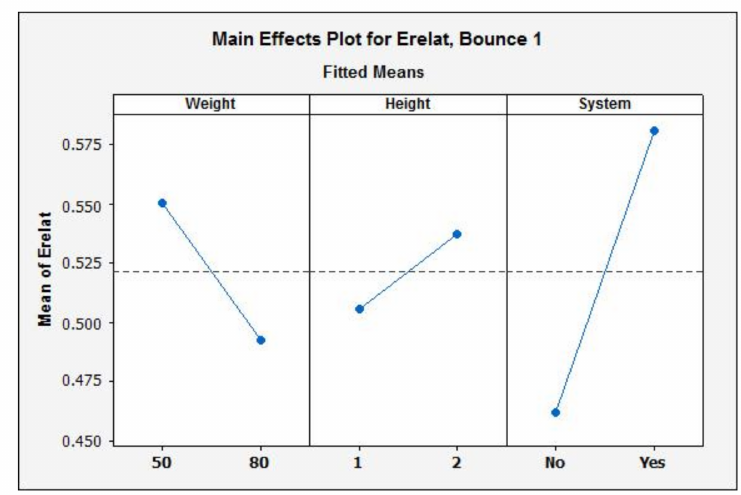
Figure 7. Graphical representation of the effects (Bounce 1).